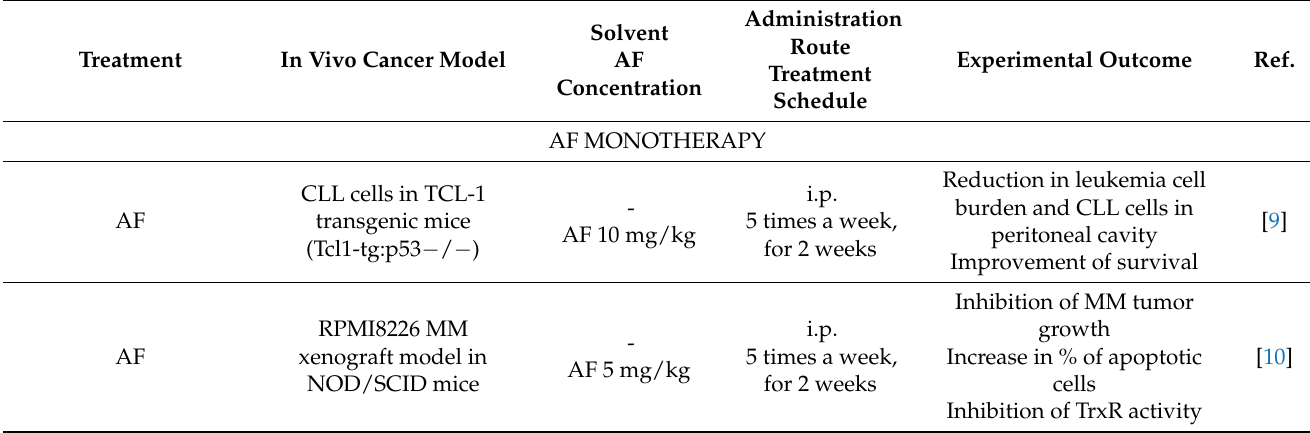
Treatment In Vivo Cancer Model